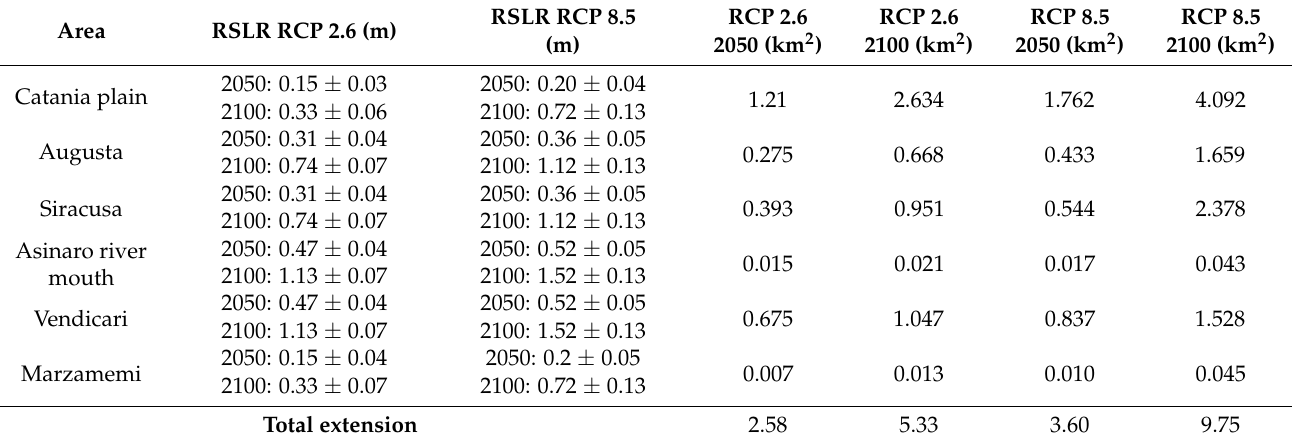
Table 2. Expected RSLR (m) and extension (km 2 ) of the exposed flooded areas for 2050 and 2100 A.D. for RCP 2.6 and RCP 8.5 emission